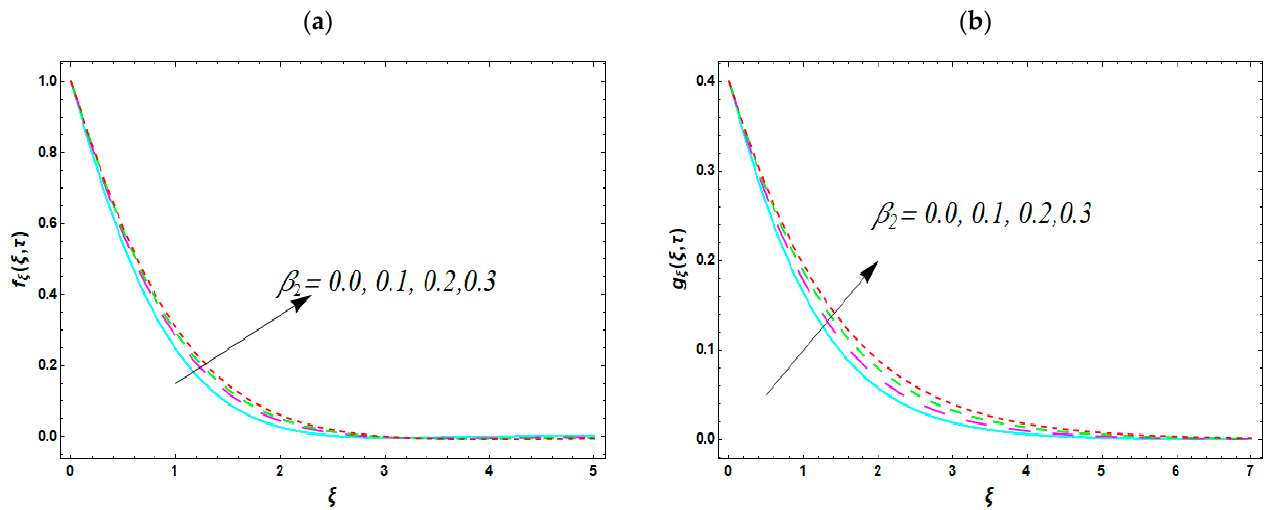
β values; ( b ) pro fi les of g ξ for various 2